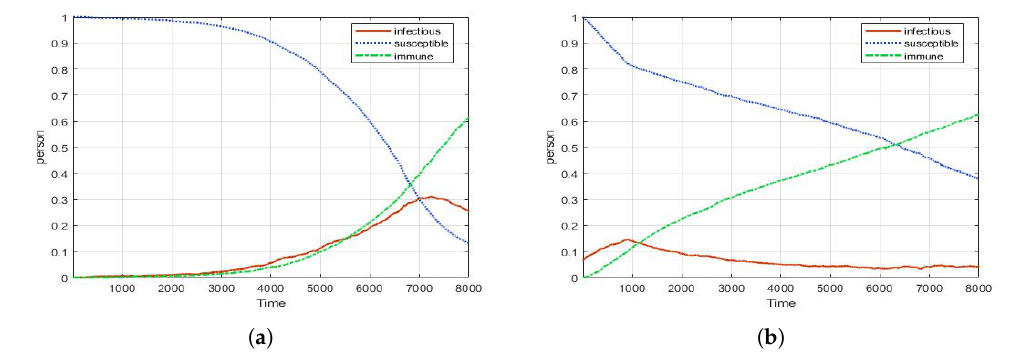
Figure 15. The graph reflecting human mannerism: ( a ) No-control (peak: 0.3); ( b ) Combination control (peak: